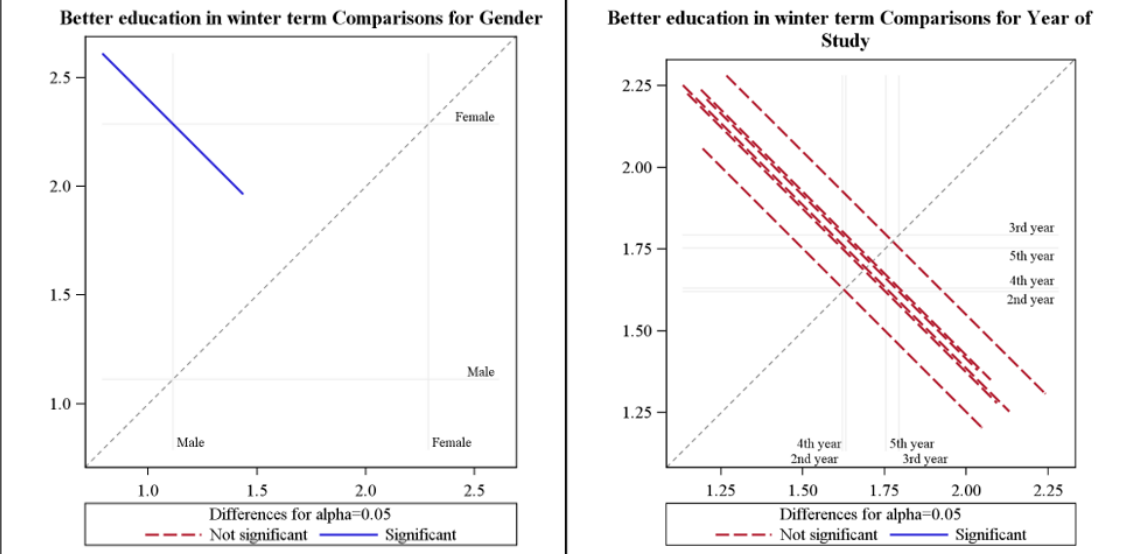
Figure 2. Comparison of LS Means of logits for gender factor and factor of year of study Source: Own processing in SAS Enterprise Guide based on own questionnaire